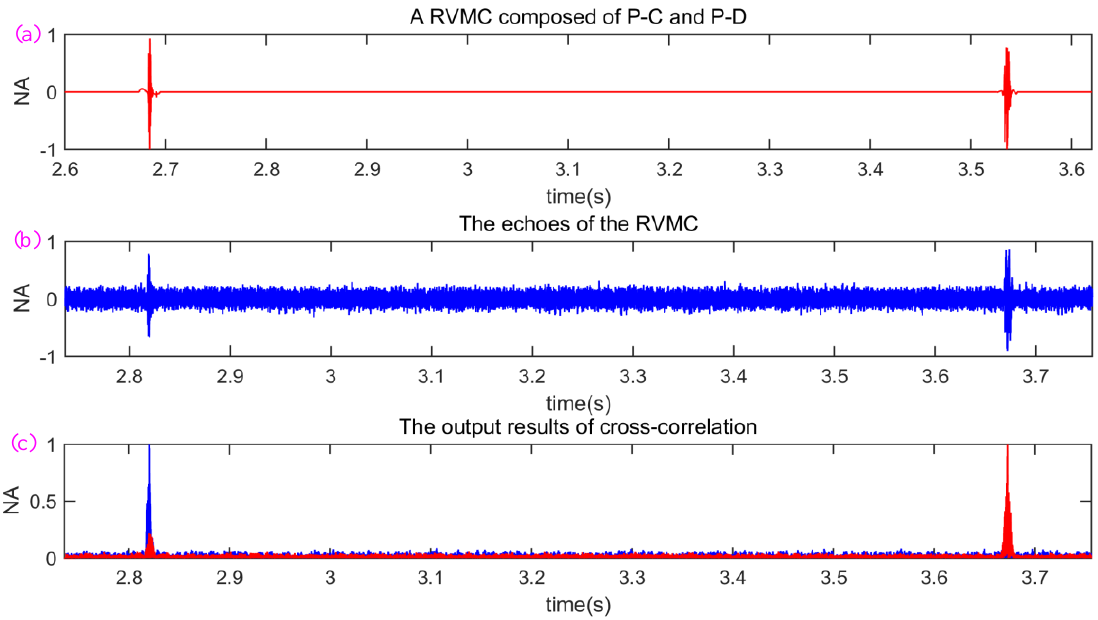
Figure 12. An example of lake experimental results. ( a ) A transmitted RVMC composed of P-C and P-D; ( b ) the echoes of the transmitted RVMC; ( c ) the output results of cross-correlation.